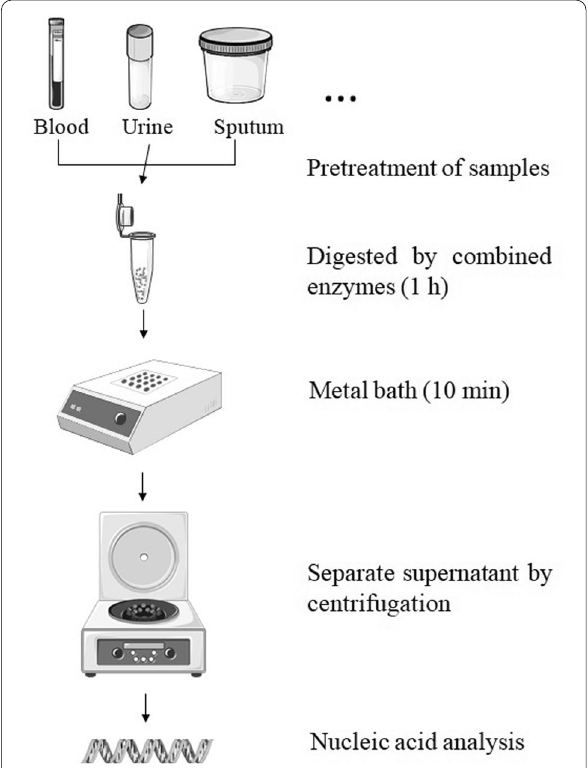
Fig. 2 Schematic of the rapid Candida DNA preparation and detection workflow. Candida blastospores were applied to enzyme digestion and high temperature metal bath after separated from pretreated clinical samples. After centrifugation, the supernatants were directly used as templates for nucleic acid analysis. The metal bath instrument was drawn by JP, and the other figure elements were taken from the free medical image site at https:// smart. servi er.